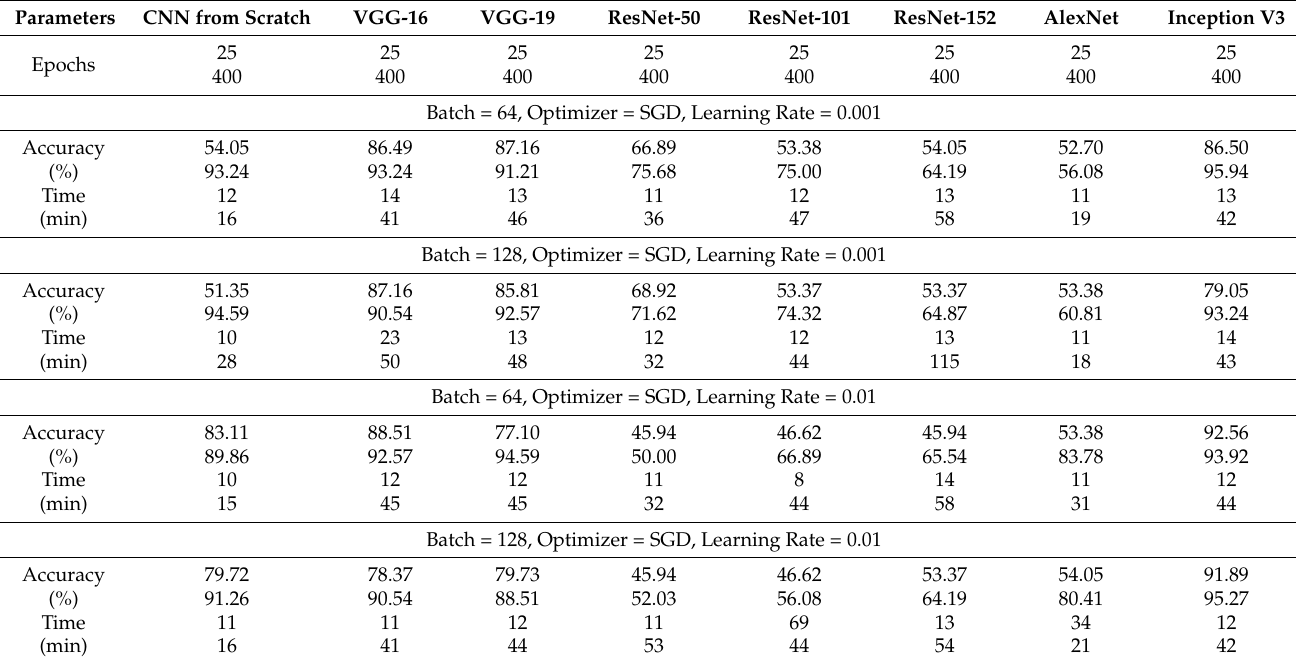
Table 3. Accuracy evaluation of eight CNNs’ architectures, changing the batch’s hyperparameters values, learning rate, and epochs, using the Stochastic Gradient Descent (SGD) parameter as an optimizer. Parameters